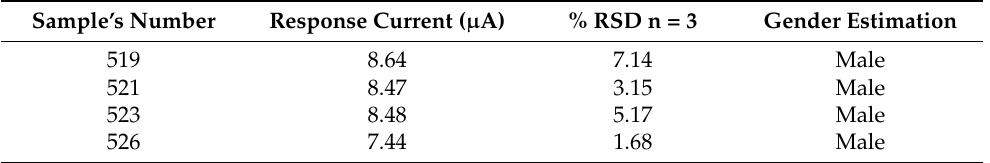
Table 1. Determination of Arowana fish gender using electrochemical DNA biosensor based on self-assembled cysteamine on gold nanoparticles and covalent bonding of ZnS QDs.